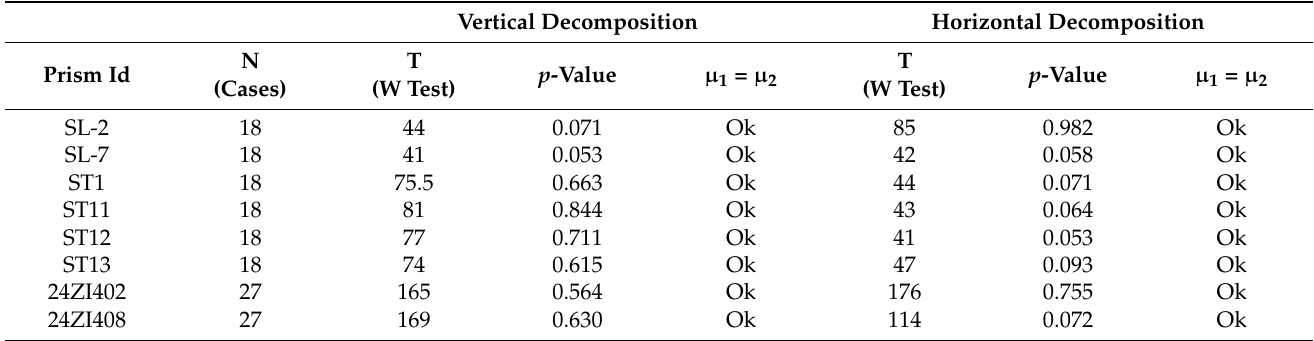
Table 5. Wilcoxon statistic test of the vertical and horizontal decomposed data. Vertical